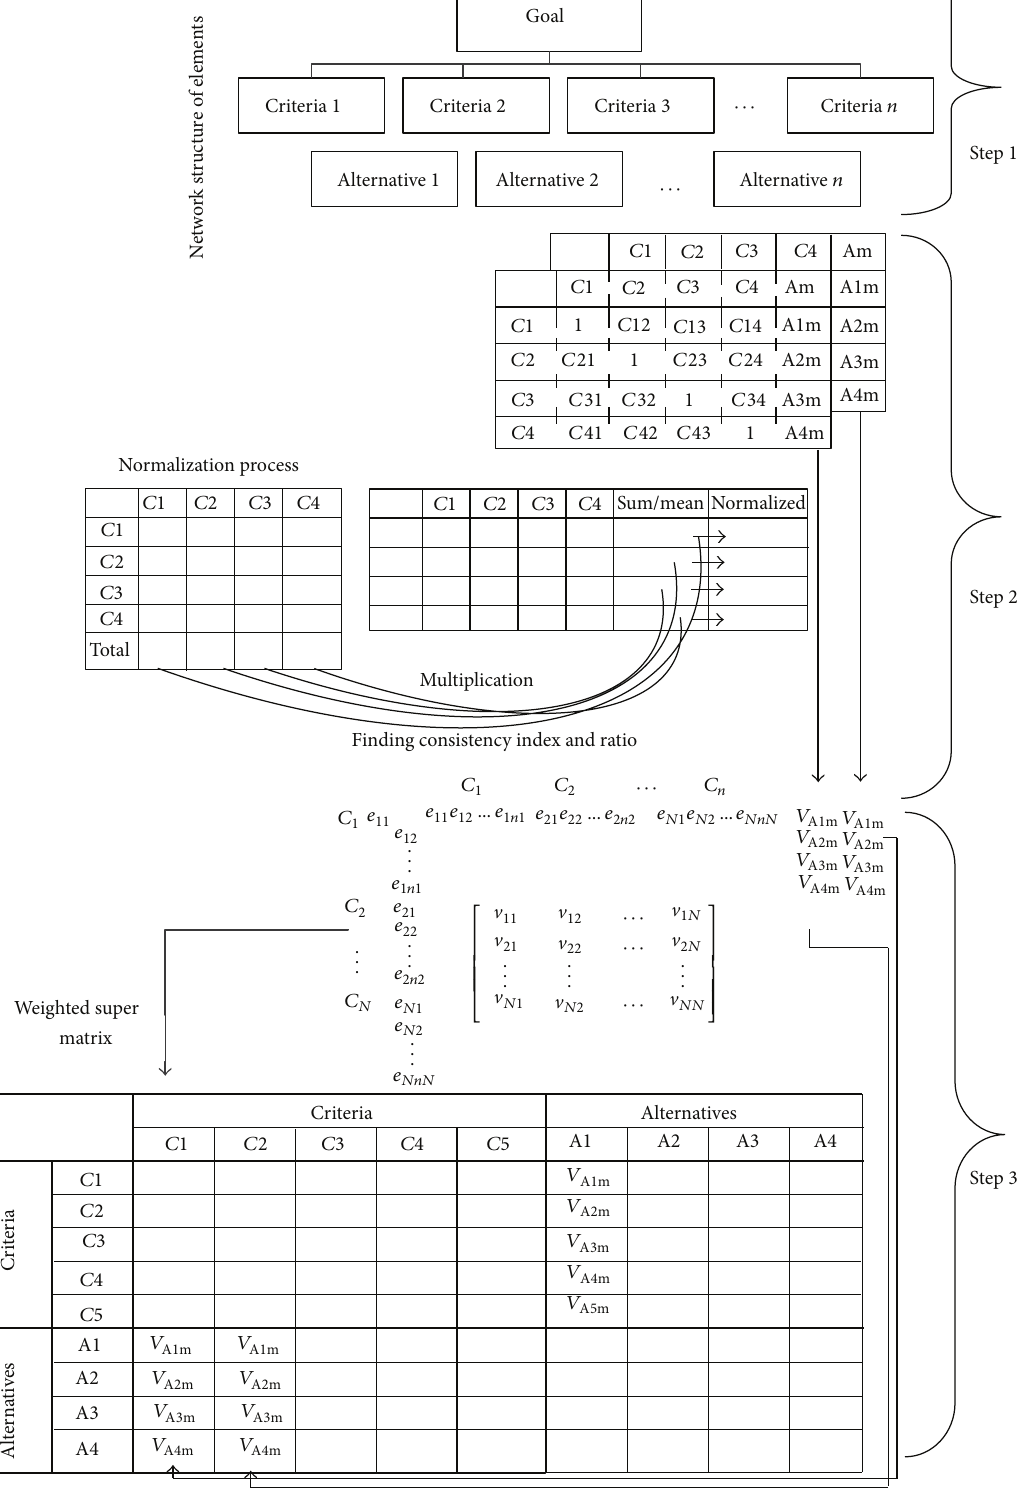
Figure 2: Graphical representation of the steps involved in ANP